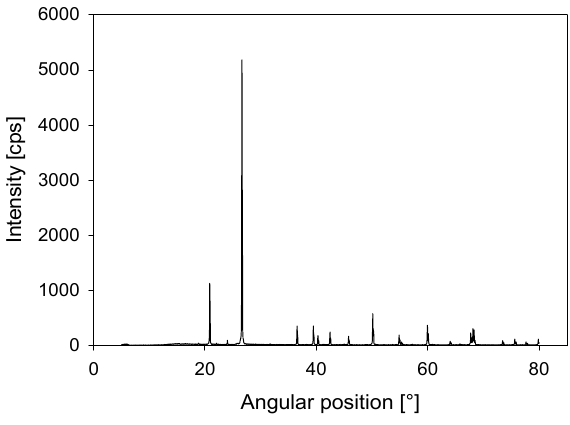
Figure 2. X-ray di ff raction (XRD) for quartz Figure 2. X-ray diffraction (XRD) for quartz powder.